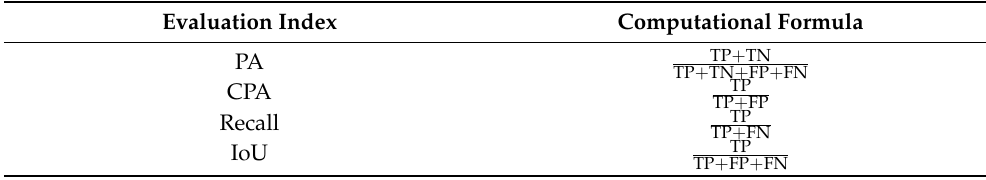
Table 2. Calculation formula for evaluation indicators.